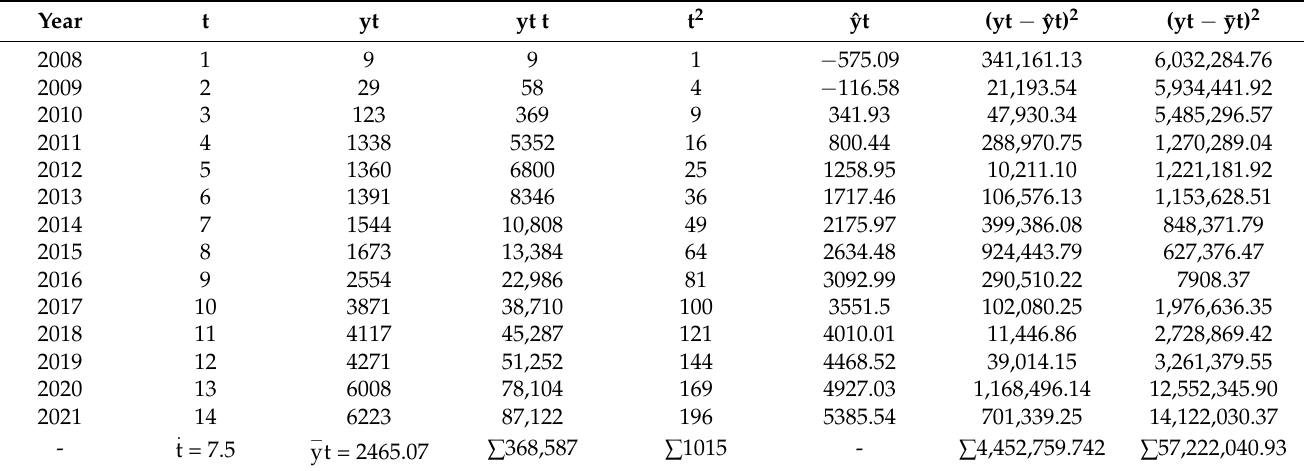
Table 2. Supporting calculations for determining the parameters of the trend function of energy recovery from biodegradable municipal waste consumption in (TJ) from 2008 to